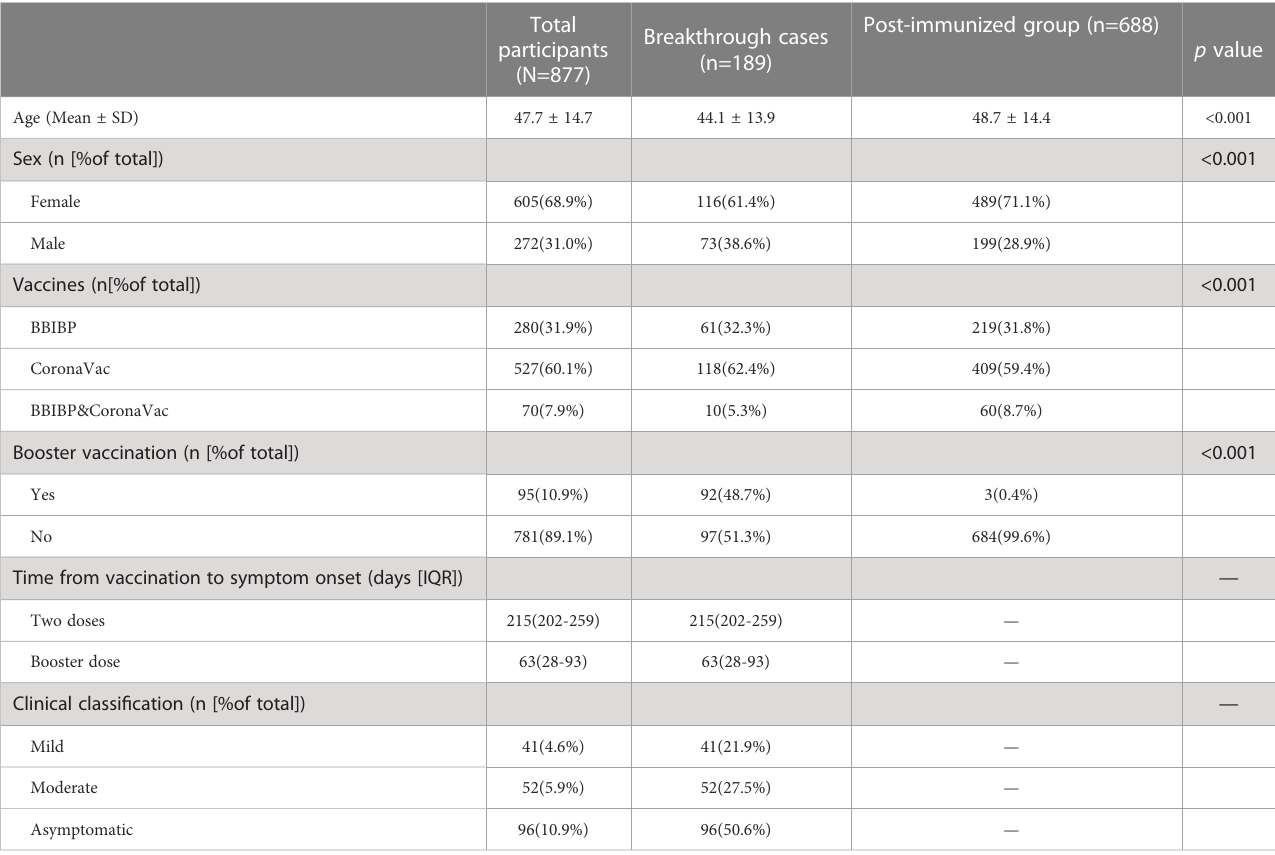
TABLE 1 Demographic baseline characteristics of the